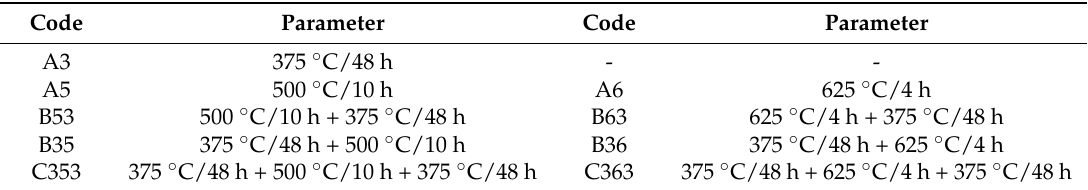
Table 1. Parameters of heat treatments used in this